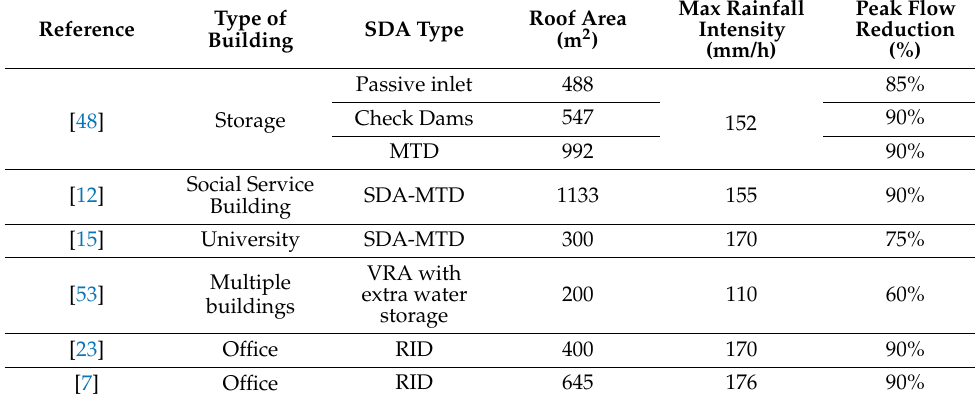
Table 1. Examples of SDA performance from literature reviews.